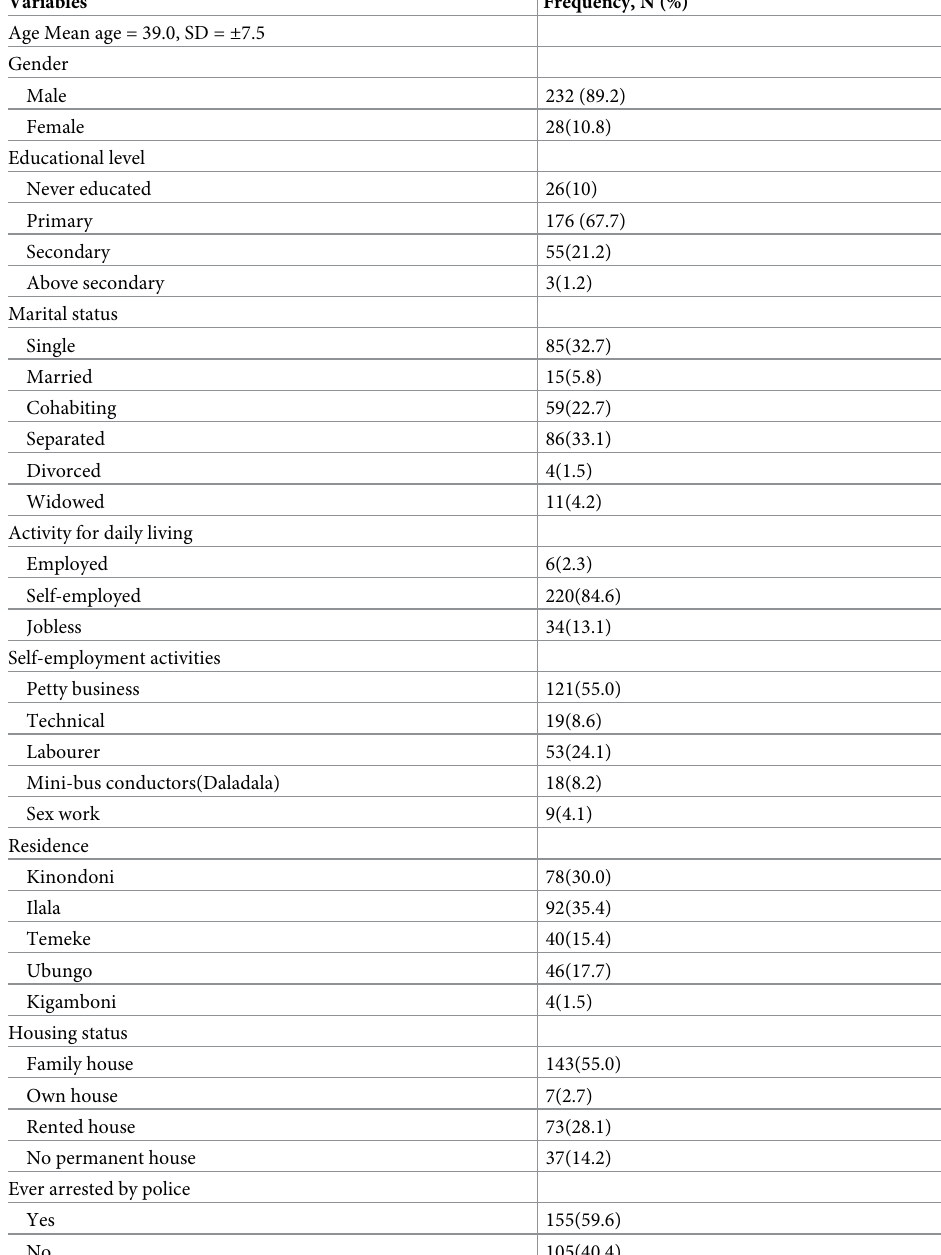
Table 1. Sociodemographic characteristics of the respondents (N = 260).